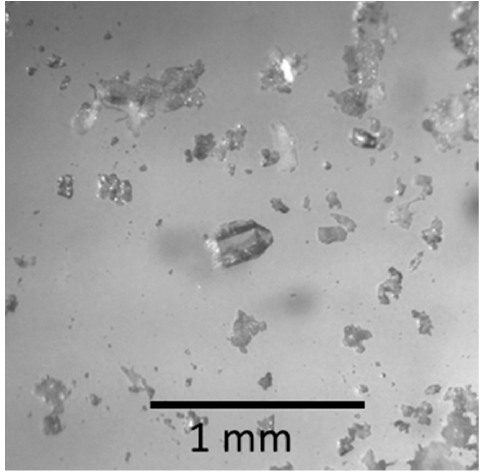
Figure 1. Colorless single crystals of NaY[SO 4 ] 2 ∙ H 2 O.